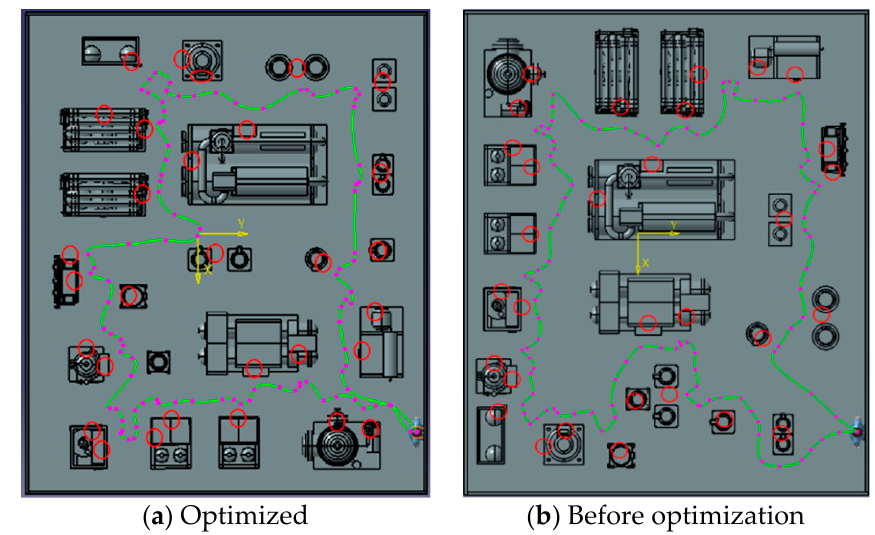
Figure 8. Schematic diagram of the main paths and task execution points.